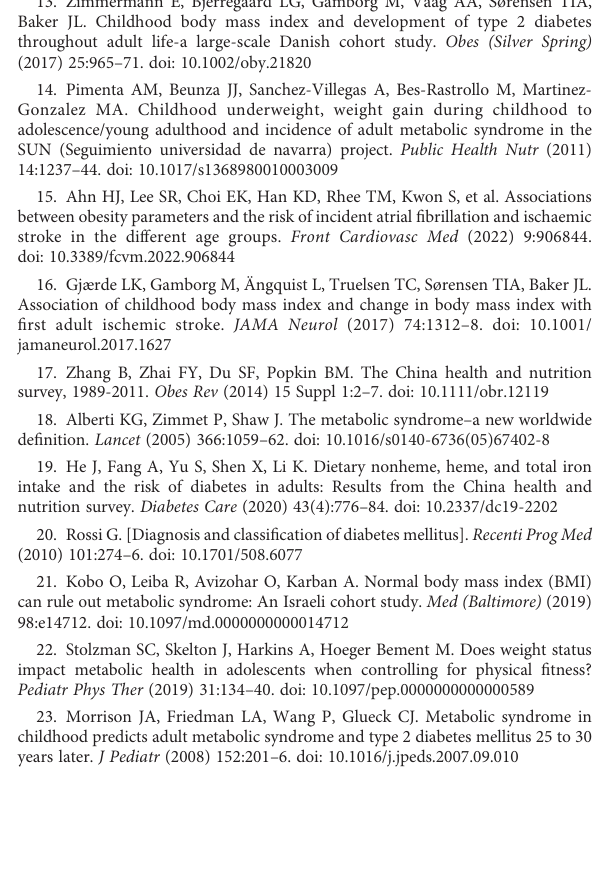
SUPPLEMENTARY FIGURE 1 Estimated and observed mean AVI values SUPPLEMENTARY FIGURE 2 The predicted trajectory of AVI with age in different genders is presented by the solid line, and 95% of the CI is represented by